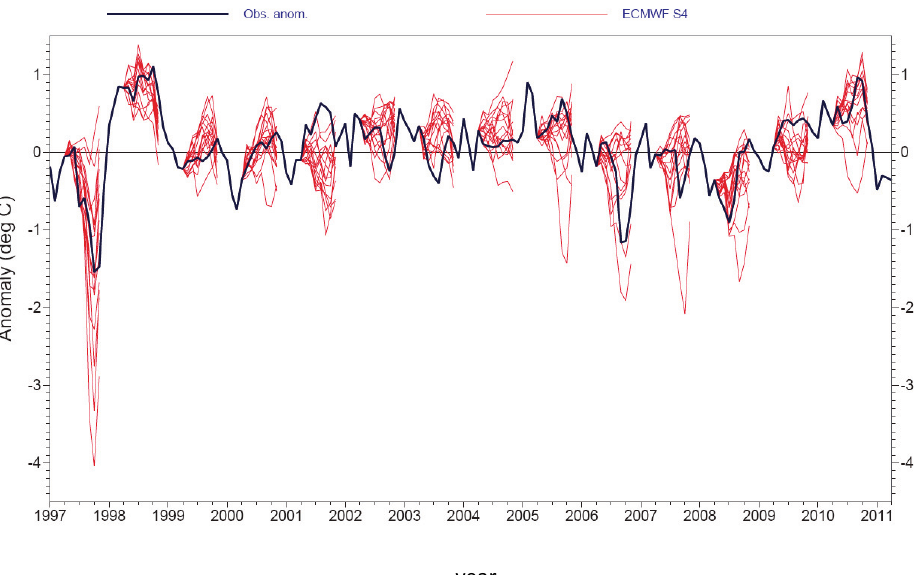
Figure 6. System 4 SST anomalies vs. observed SST anomalies over the Indian ocean (0 ◦ –10 ◦ S, 90 ◦ –110 ◦ E), 1997–2010. In this figure the variance has been corrected to match the variance of the observations. The observed anomalies are derived from ERA Interim and the forecasts shown are based on the S4 hindcast system with 15 ensemble